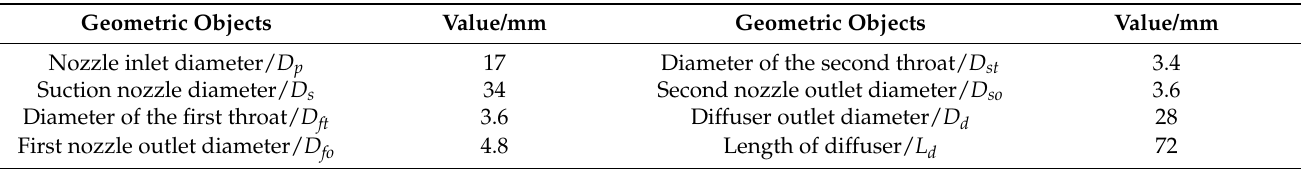
Table 1. Key structural sizes for the two-throat nozzle